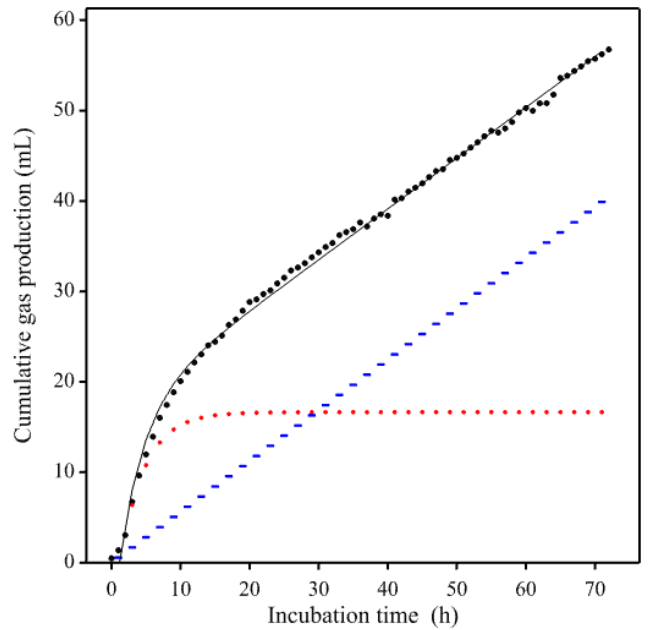
Figure 4. Example of a non-standard gas production curve taken from Garber et al. [19] (curve for a hay treated with 0.75 mL enzyme solution per kg dry mater and incubated with an equine fecal inoculum) showing an additional linear trend (in blue) covering the asymptotic region of the underlying growth-like curve (in red). The continuous black line shows the fitted model (a generalized Mitscherlich + linear) and the dots represent observed data points (those taken 2 hourly).